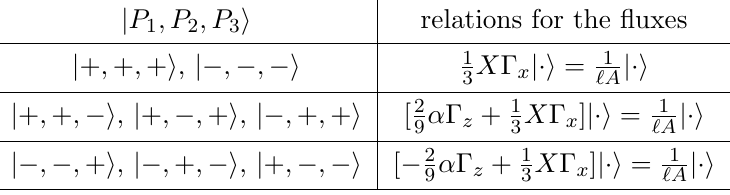
Table 8 . Decomposition of (4.74) KSE into